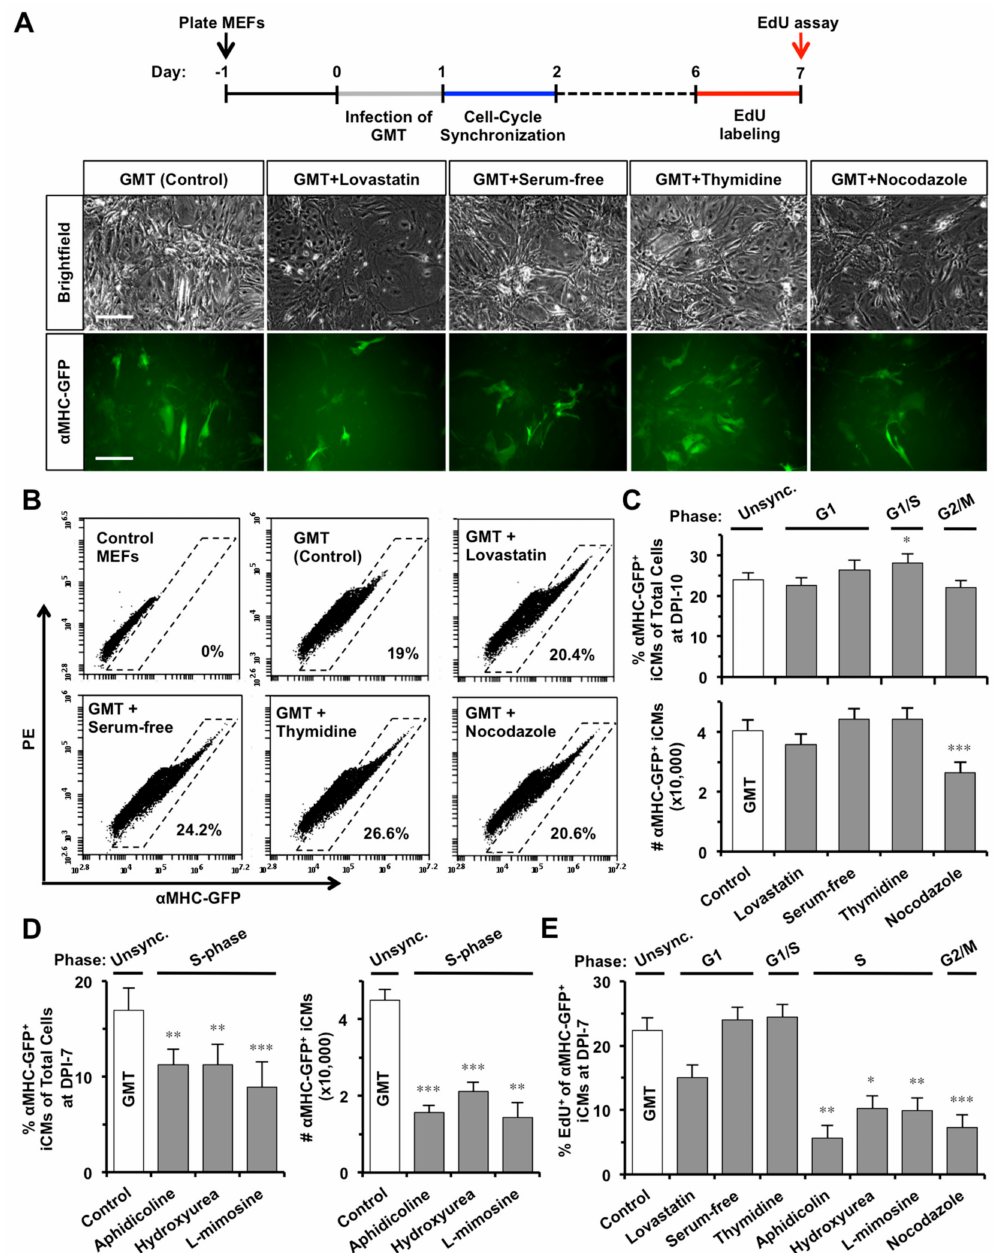
Figure 2. S- or G2/M-phase synchronization at DPI-1 enhances cell-cycle exit in GMT-reprogrammed iCMs. ( A ) At DPI-1, MEFs were synchronized at G1, G0/G1, G1/S, or G2/M-phase by lovastatin, serum-free media, thymidine, or nocodazole, respectively. Representative pictures showing GMT-reprogrammed MEFs at DPI-10 with or without (Control) cell-cycle synchronization. Scale bars indicate 100 µ m. ( B ) Representative FACS plots of reprogrammed α MHC-GFP + iCMs at DPI-10. ( C ) The effect of G1-, G1/S-, or G2/M-phase synchronization on GMT-iCMs ( n = 10), including